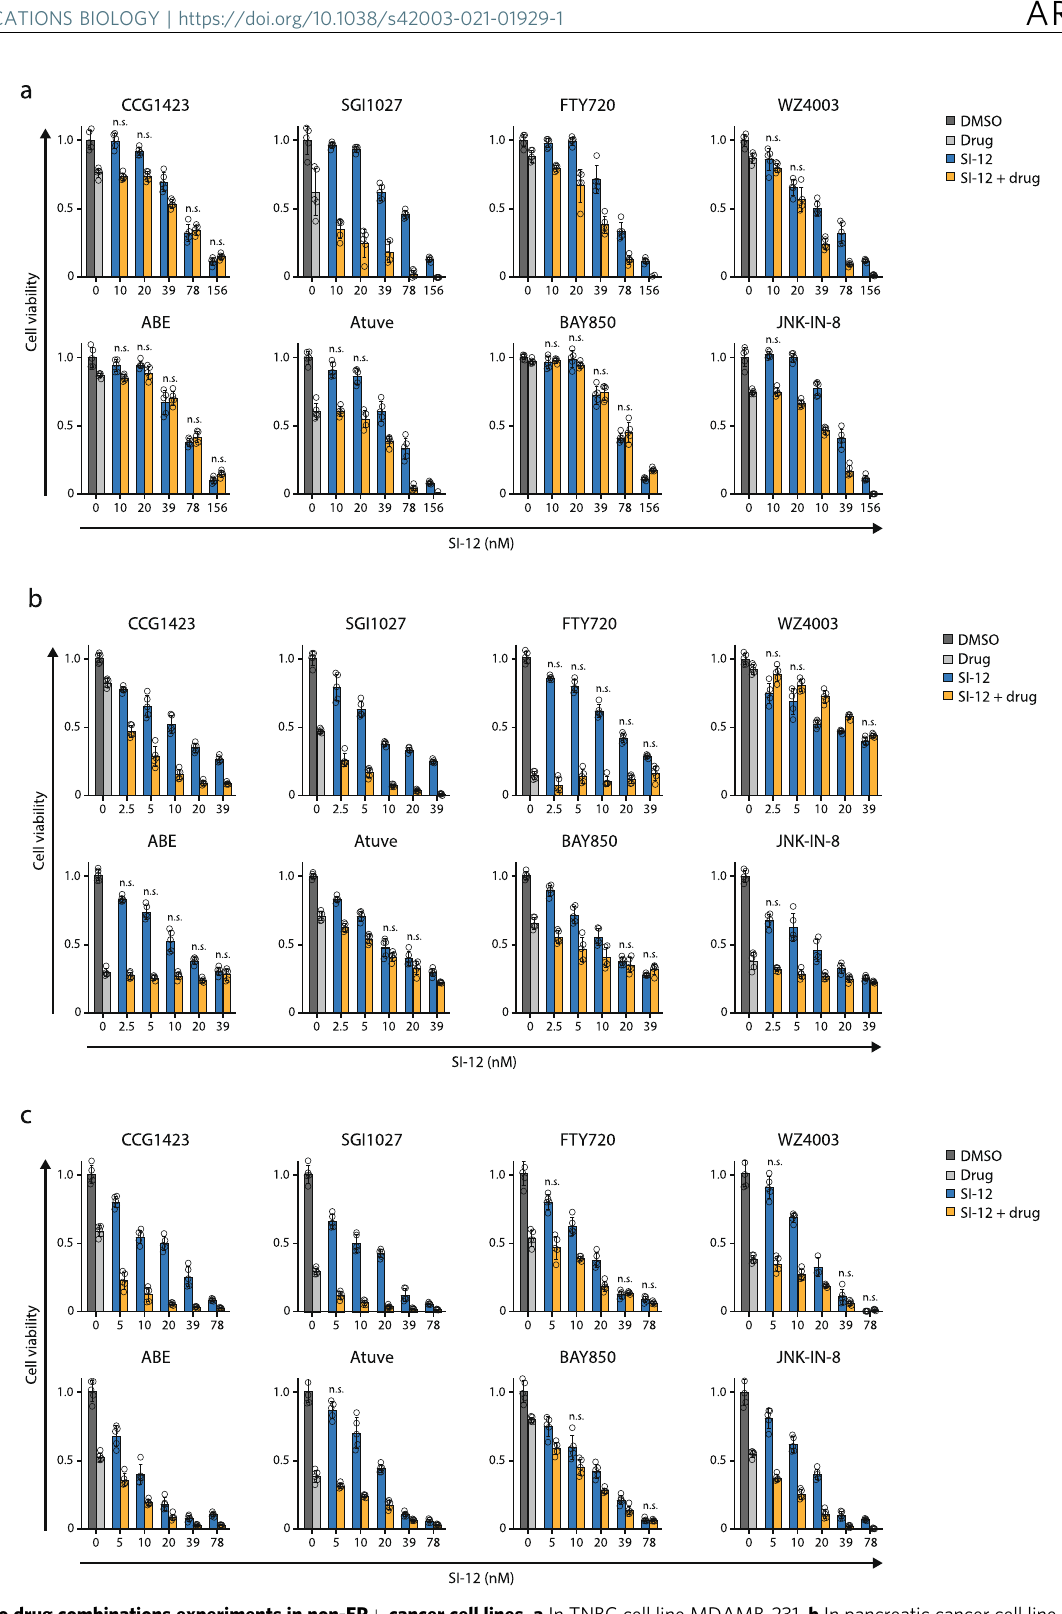
Fig. 6 In vitro drug combinations experiments in non-ER + cancer cell lines. a In TNBC cell line MDAMB-231. b In pancreatic cancer cell line PANC-1. c In prostate cancer cell line LNCaP. Cells were plated in 96 well plates and treated with the indicated compound(s) for 96 h. At the end of the drug treatment period, the cells were subjected to an MTS viability assay. For drug concentrations see Table 1. Each point re fl ects at least four technical replicates. Each cell viability plot represents at least two independent experiments showing similar results. Statistical signi fi cance compares between the combo and the most effective single agent (either SI-12 at relevant concentration, or the partner molecule) ***For all the results P < 0.0005, two-tailed Student ’ s t -test, if not mentioned otherwise. ns not signi fi